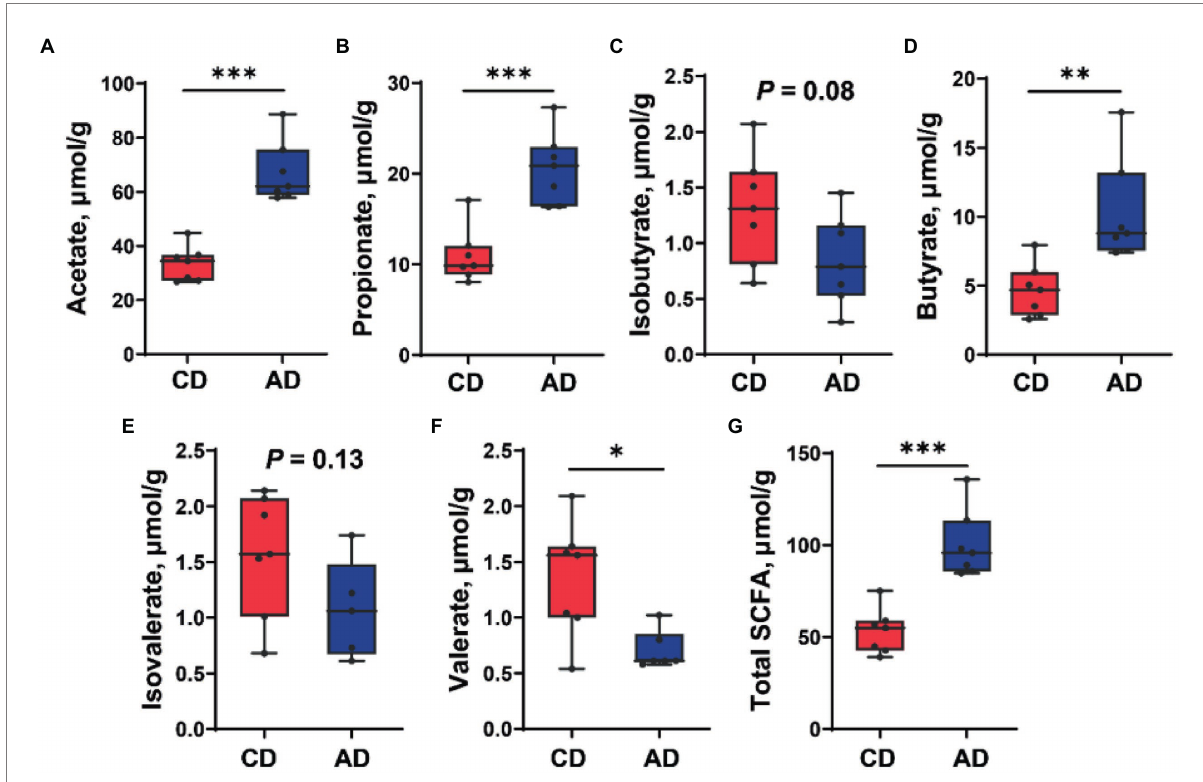
FIGURE 6 Short-chain fatty acids (SCFAs) concentration in colonic digesta of pig in CD and AD groups. Concentration of (A) Acetate, (B) Propionate, (C) Isobutyrate, (D) Butyrate, (E) Isovalerate, (F) Valerate, and (G) Total SCFA. * p < 0.05, ** p < 0.01 and *** p < 0.001. CD, control diet; AD, alfalfa